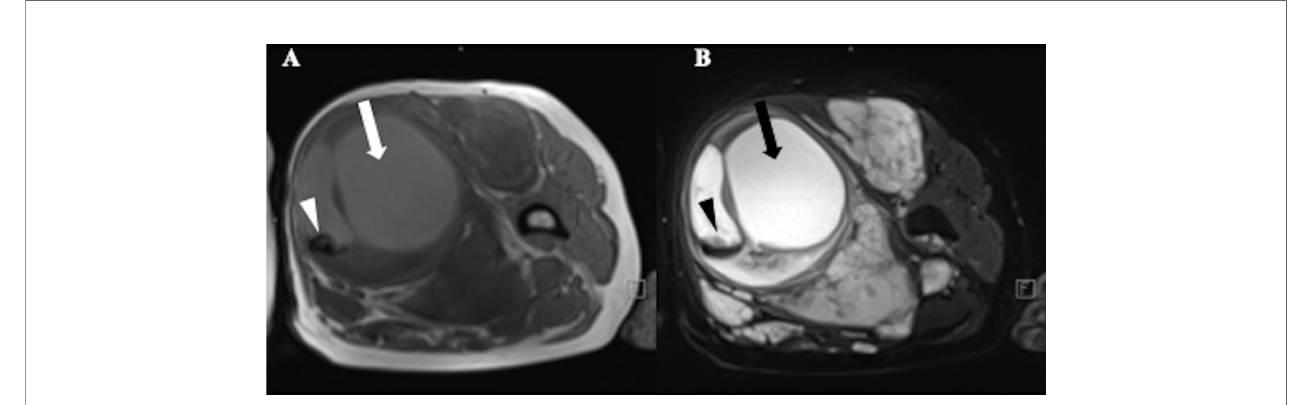
FIGURE 3 | A 52-year-old female with Neuro fi bromatosis type 1 (NF1) who presented with a large mass in soft tissue of upper left thigh. MRI showed a heterogeneous signal with cystic change (arrows) and hemorrhage (arrowheads) in the mass, suggestive of malignant transformation. (A) T1-weighted MR image; (B) T2-weighted MR